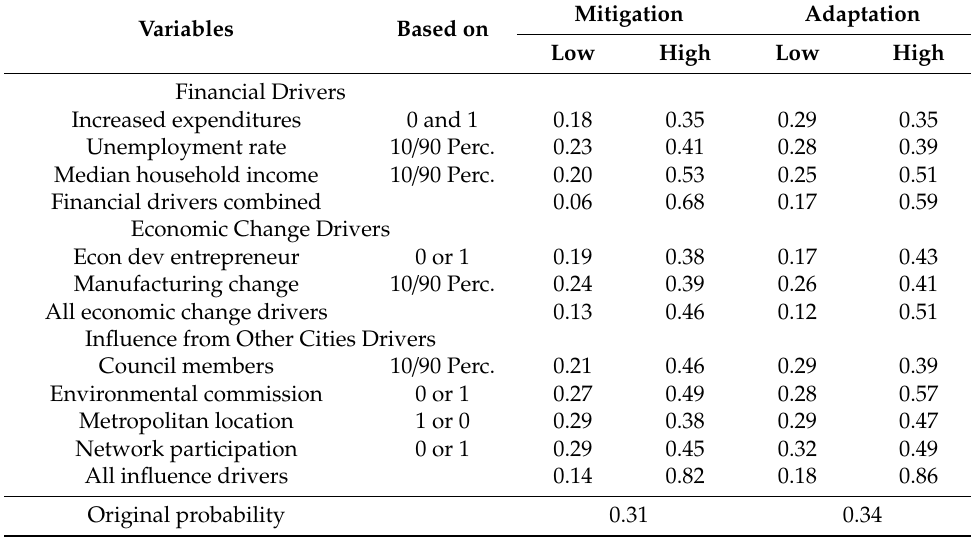
Table 4. Summary of predicted probabilities for likelihood of high